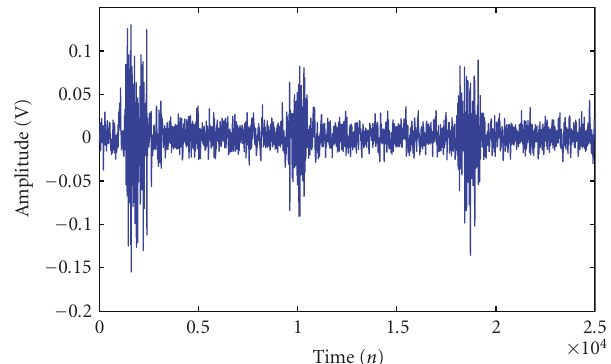
Figure 4: A 12-second sample input signal, where each burst is an utterance of a word, that is, “one,” “two,” “three,” and so forth.